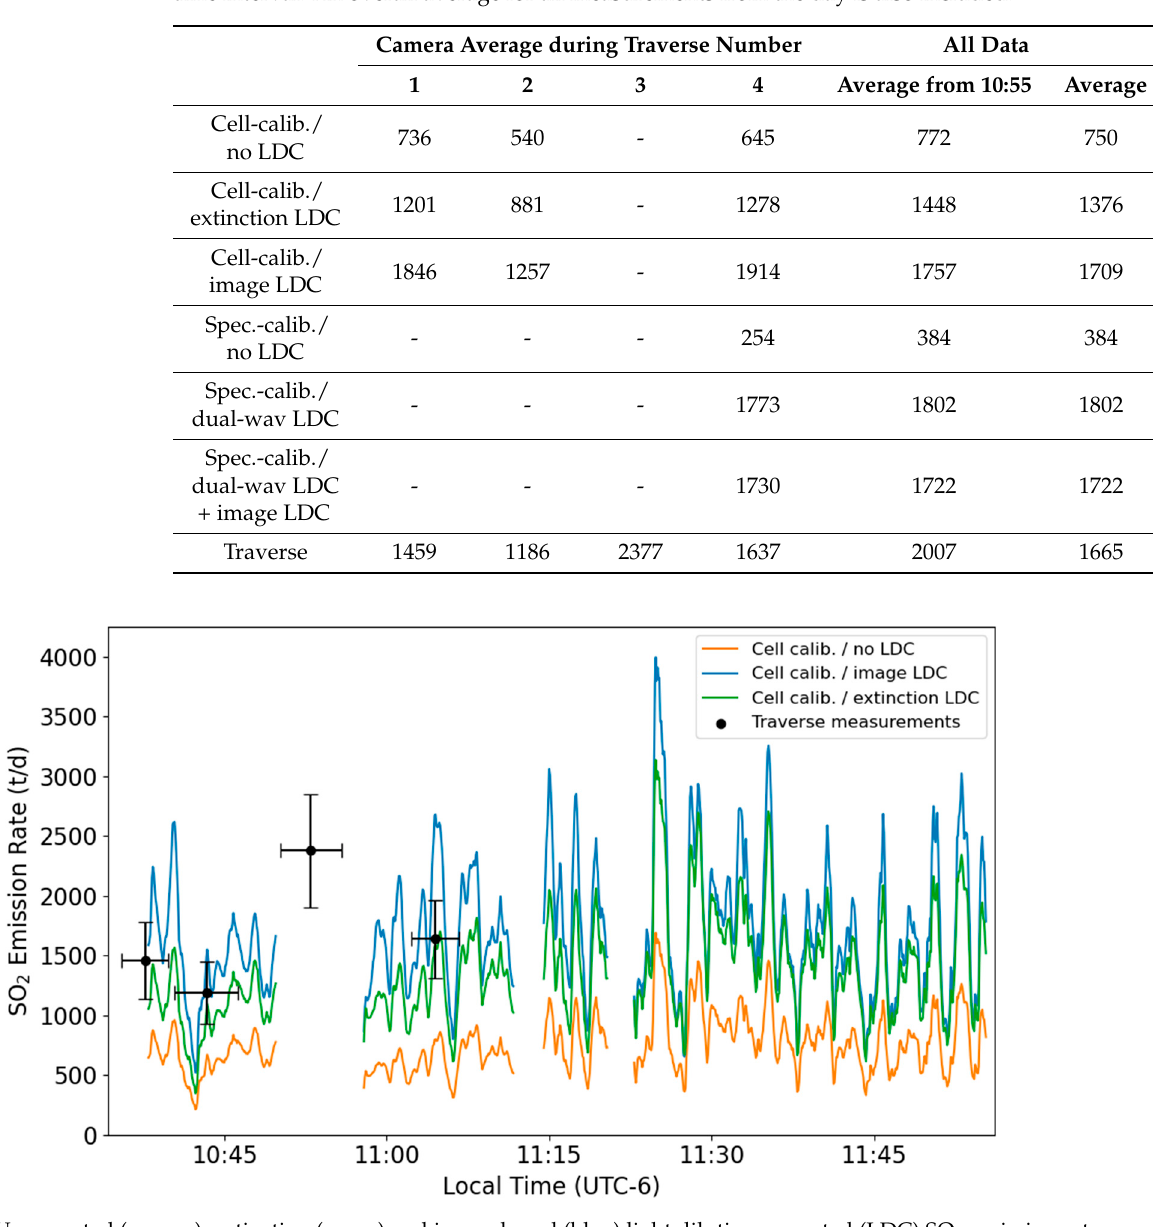
Figure 8. Uncorrected (orange), extinction (green) and image-based (blue) light dilution-corrected (LDC) SO 2 emission rate 15 January 2018 as measured by the SO 2 camera. Simultaneous traverse emission rates, shown in black, are plotted at the time measured at the center of mass of the traverse minus the travel time from SO 2 camera measurement line to traverse road. The traverse error accounts for the duration of the traverse and the error in plume speed estimate from the camera.